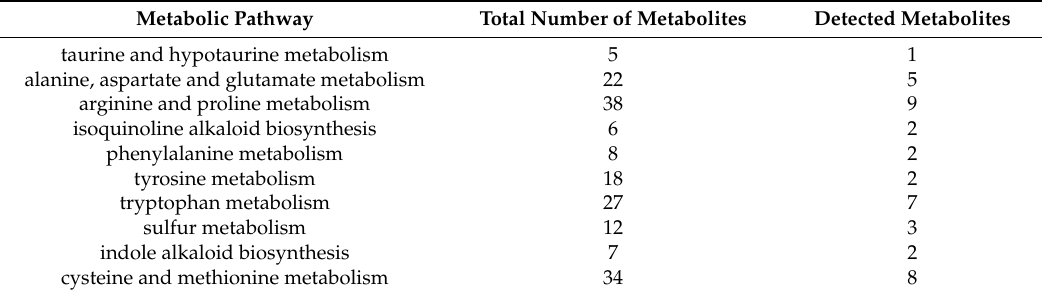
Table 1. Metabolic Pathway of black and white sesames. 217 out of 557 metabolites were putatively identified. Pathway analysis conducted at MetaboAnalyst 3.0 reflected that these 217 metabolites covered 30